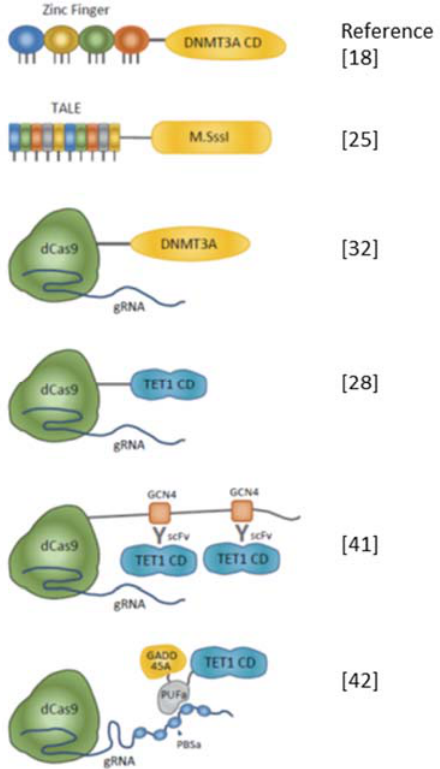
Figure 1. Schematic diagrams of artificial enzymes for editing DNA methylation. Representative combinations of DNA-binding modules and effectors are shown. Zinc finger, transcription activator-like effector (TALE), and dCas9 with guide RNA (gRNA) complex are used for DNA-binding modules. DNMT3A or M.SssI are effectors of inducing DNA methylation. To remove DNA methylation, the catalytic domain (CD) of TET1 is fused with DNA binding module. SunTag technology enables multiple copies of TET1 CD to be introduced to the target region [41]. There has been a report describing the tethering of both TET1 CD and base excision repair (BER)-related proteins such as GADD45A to improve the efficiency of DNA demethylation [42].